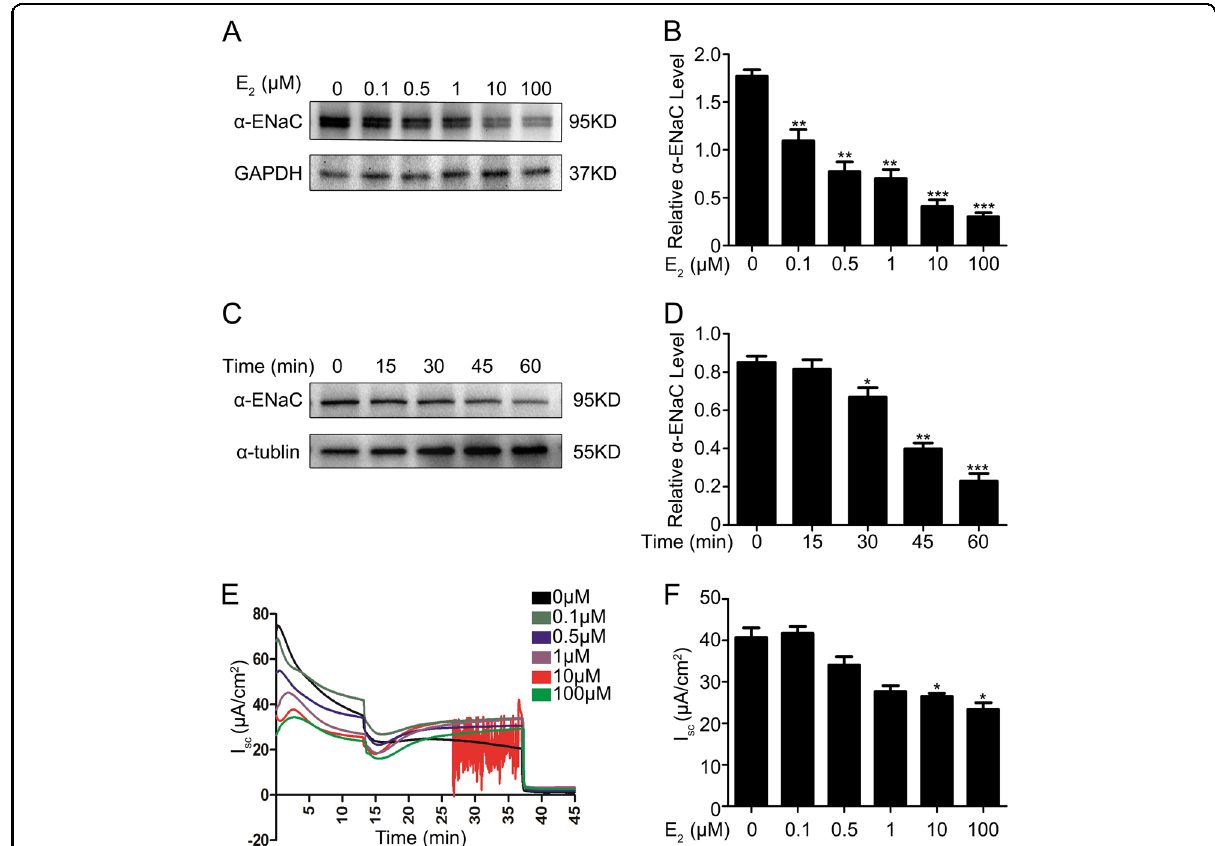
Fig. 3 Estrogen suppresses the expression of ENaC in mpkCCDc14 cells. a Endogenous α -EnaC expression was dose-dependently decreased by E 2 treatment in mpkCCDc14 cells, as determined by western blot analysis. b Quantitation of the western blot data for the EnaC protein from a . The bars are the means±SE values from three independent experiments. * P< 0.05, **P< 0.01, and ***P< 0.001 compared to the Con group. c E 2 suppressed the protein expression of α -ENaC in mpkCCDc14 cells during a time course, as detected by western blot analysis. d The mean time-course data for α -ENaC expression in C normalized to α -tubulin expression. The bars are the means±SE values from three independent experiments. * P< 0.05, **P< 0.01, and ***P< 0.001 compared to the Con group. e Typical traces of short-circuit current (Isc, μ A/cm 2 ) across mpkCCDc14 cell epithelia under E 2 treatment at a series of concentrations. The arrows indicate the time of addition of 10 μ M amiloride to the apical bath. f Amiloride-sensitive Isc from all experiments of the type shown in ( e ); the data are from four epithelia studied under each condition. * P< 0.05 compared to the Con concentration series data on phosphorylated AMPK expression from all experiments are summarized in Fig. 8b. Similarly, E time-dependently induced AMPK 2 phosphorylation in mpkCCDc14 cells (Fig. 8c). The mean time-course data for phosphorylated AMPK expression are shown in Fig. 8d.